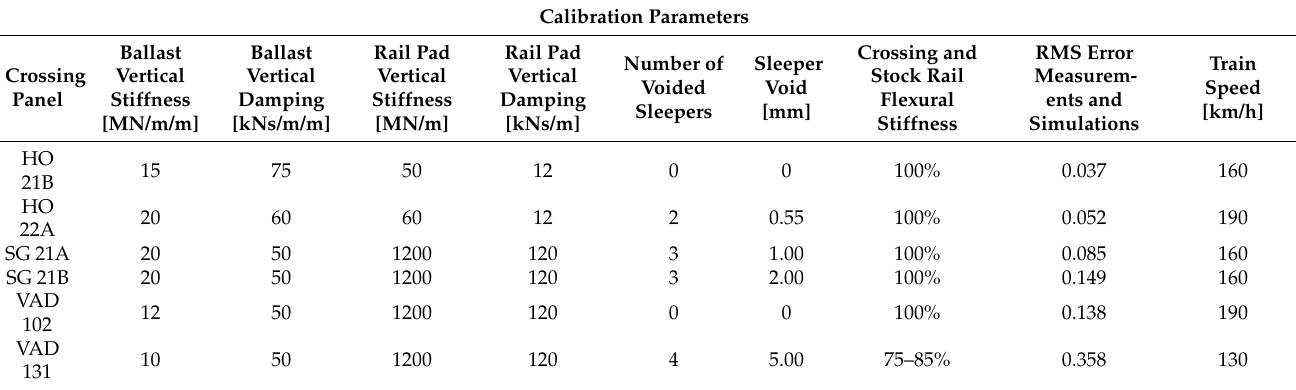
Table 6. Summary of calibrated track model